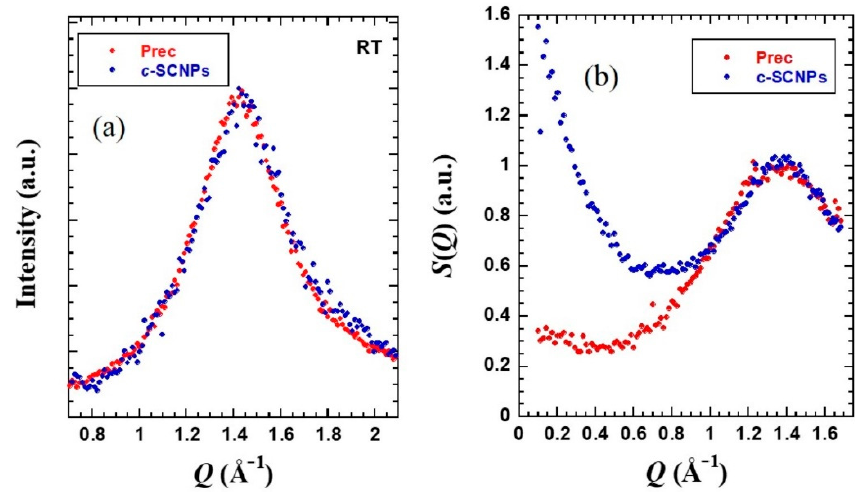
Figure 3. ( a ) WAXS diffraction patterns determined at room temperature for precursor and c -SCNPs. ( b ) Static structure factor obtained by IN11c on precursor and c -SCNPs at 320 K. In both cases data have been scaled to match at the maximum.